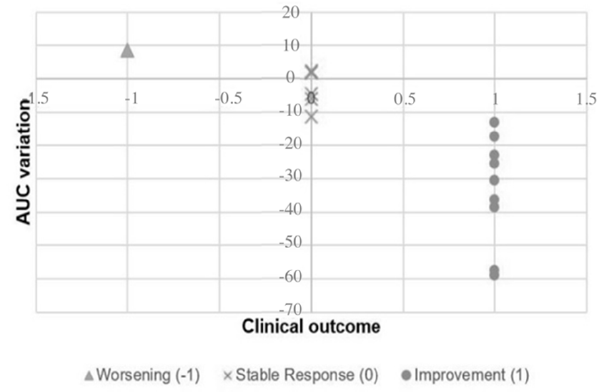
Figure 5. AUC variation correlated to patients’ outcomes.